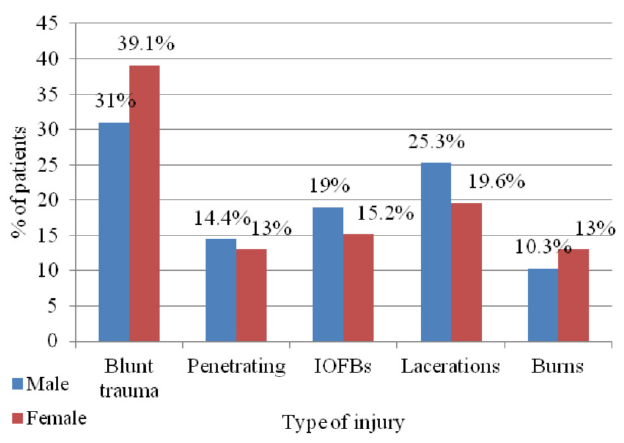
Figure 1. Type of injury in relation to the gender of the patients Ocular signs and